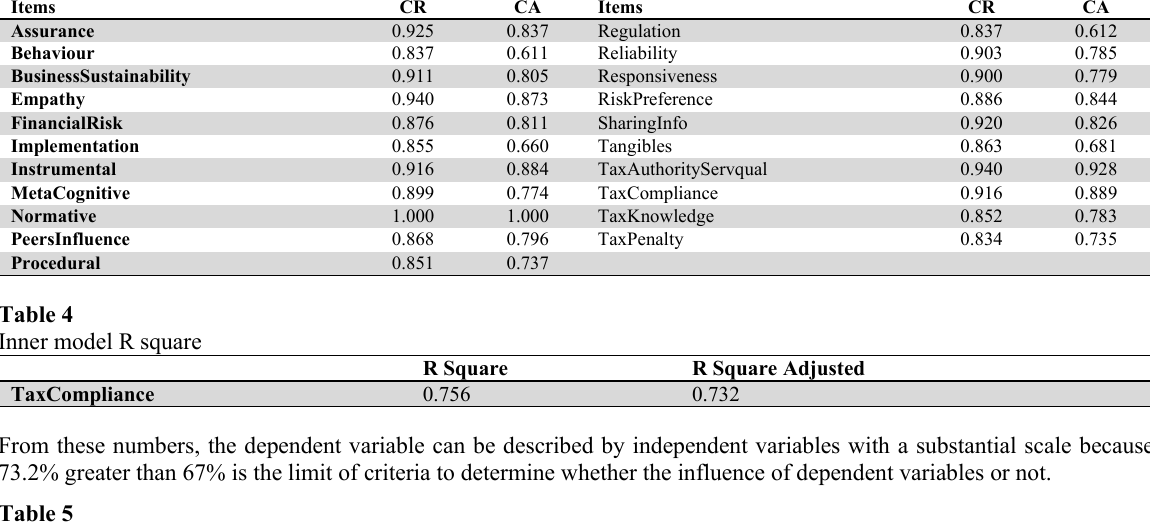
Path Analysis Path